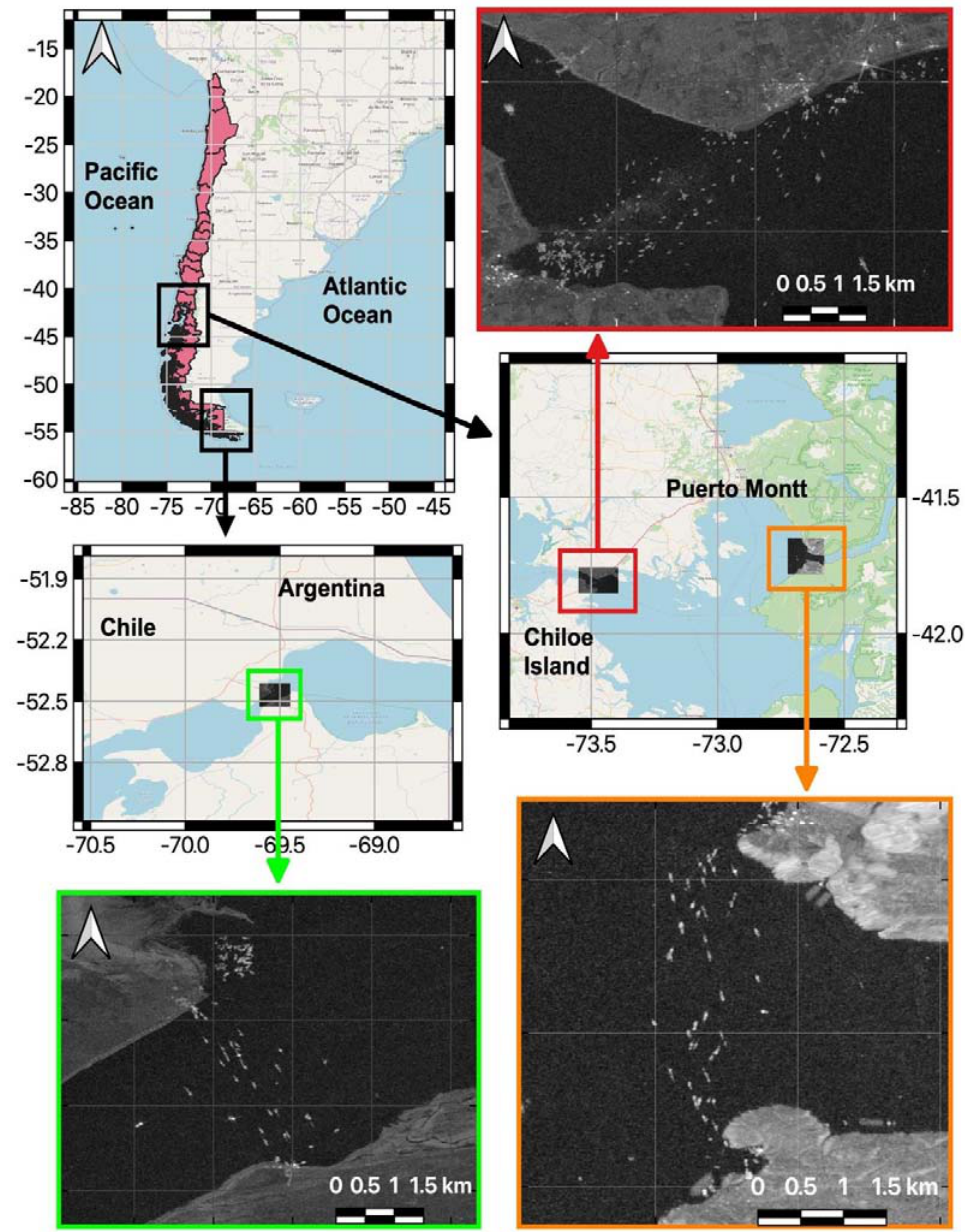
Figure 1. Location of the three sites in Latin America evaluated in this study: Chacao Channel, Reloncavi Estuary and Strait of Magellan, and SAR images displayed for each region.